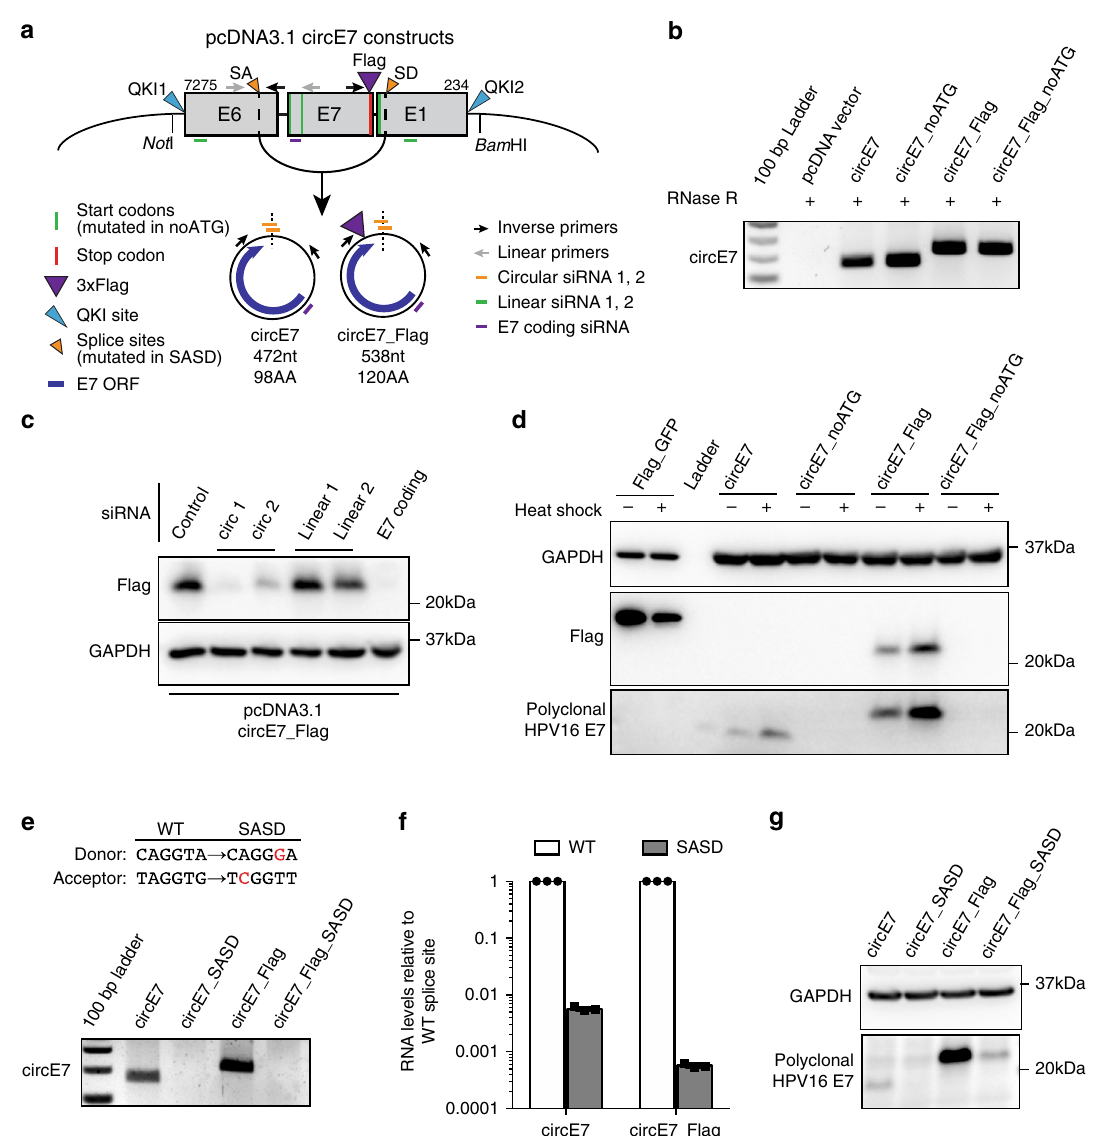
Fig. 2 Generation and translation of circE7. a Diagram of constructs generated to express circE7 in vitro. Map indicates location of QKI sites, start codons (all mutated in ‘ noATG ’ ), 3xFLAG (present in ‘ FLAG ’ ), splice sites (mutated in ‘ SASD ’ ), and siRNA used in subsequent experiments. b RT-PCR con fi rms the formation of RNase R-resistant circE7 RNAs from transfected 293 T cells. Results representative of >6 independent experiments. c Western blot for FLAG from 293 T cells co-transfected with circE7_FLAG and the indicated siRNA. GAPDH, loading control. Results representative of 4 independent transfections. d Western blots for FLAG and HPV16 E7 from 293 T cells transfected with the indicated circE7_FLAG construct (4 μ g) or a linear FLAG-GFP control vector (0.4 μ g). Indicated transfections were subjected to a heat shock (2 h at 42 °C, 2 h recovery). Eight-fold less lysate was loaded for control FLAG-GFP transfected cells. GAPDH, loading control. Results representative of 5 independent experiments. e RT-PCR demonstrates that splice sites indicated in a are required for the formation of circE7 RNAs. f RT-qPCR from 293 T cells transfected with pcDNA3.1-circE7 constructs con fi rms signi fi cantly lower circRNA formation in the SASD mutants. Results representative of 3 independent experiments. g Western blots for HPV16 E7 from 293 T cells transfected with the indicated circE7 construct (4 μ g). GAPDH, loading control. Source data for b , d , e , and g provided in Source Data fi backsplice junction, the linear mRNA, or a region shared by both linear and circular species (Fig. 2a). RT-PCR con fi rmed that siRNAs against the circE7 backsplice preferentially knocked down the circular transcript; those against linear E6/E7 preferentially depleted the linear transcript; and those targeting E7 knocked down both RNAs (Supplementary Fig. 3e). Notably, knockdown of circE7 or shared regions of the E7 ORF inhibited the expres- sion of E7 protein. In contrast, siRNAs targeting the linear RNA did not strongly decrease E7 expression by western blotting (Fig. 2c). CircRNAs are predicted to be translated through a cap-independent mechanism, which can be upregulated by cell